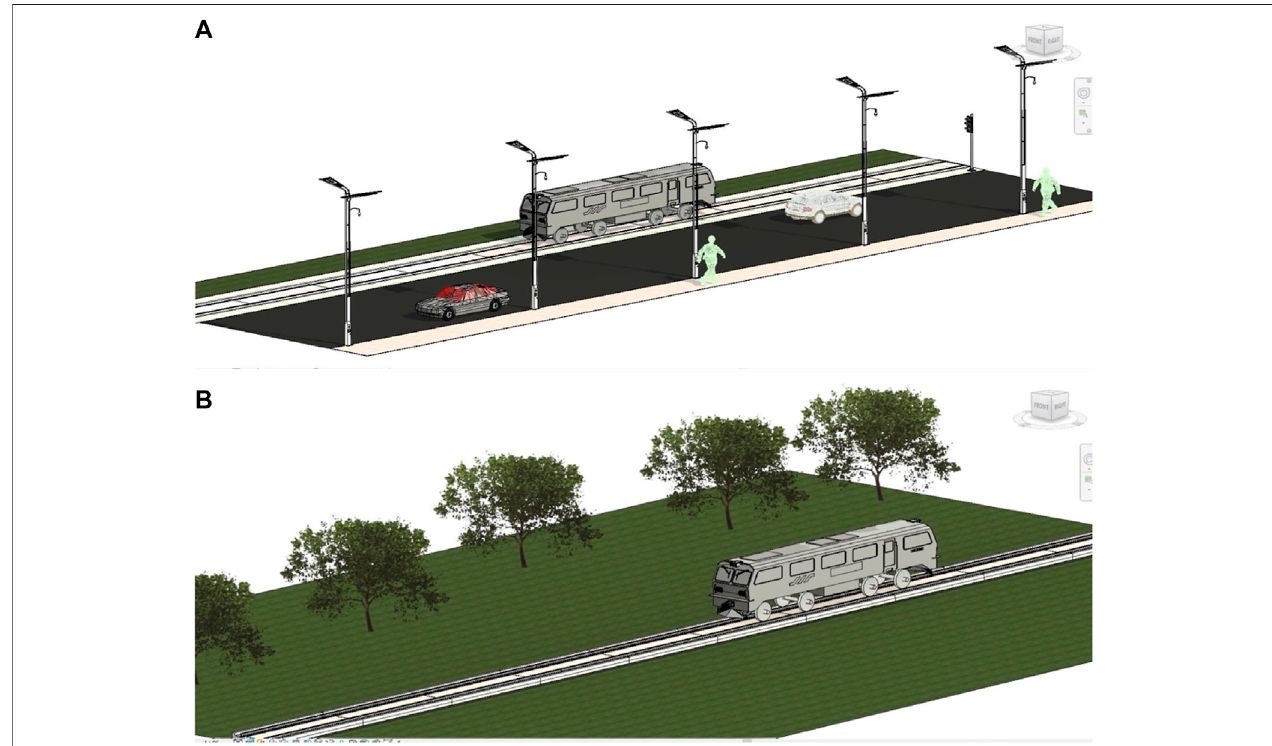
FIGURE 10 | BIM models of on-street and off-street light rail systems. (A) On-street light rail 3D. (B) Off-street light rail 3D.